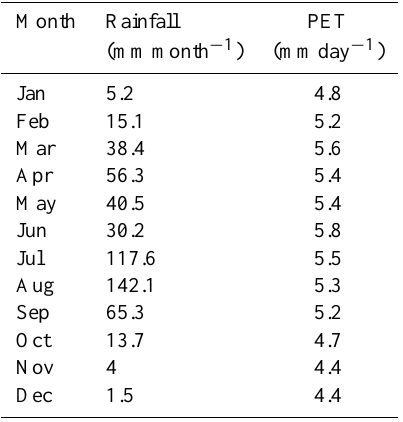
Table 1. Long-term average (1961–1990) rainfall and PET in the Awash